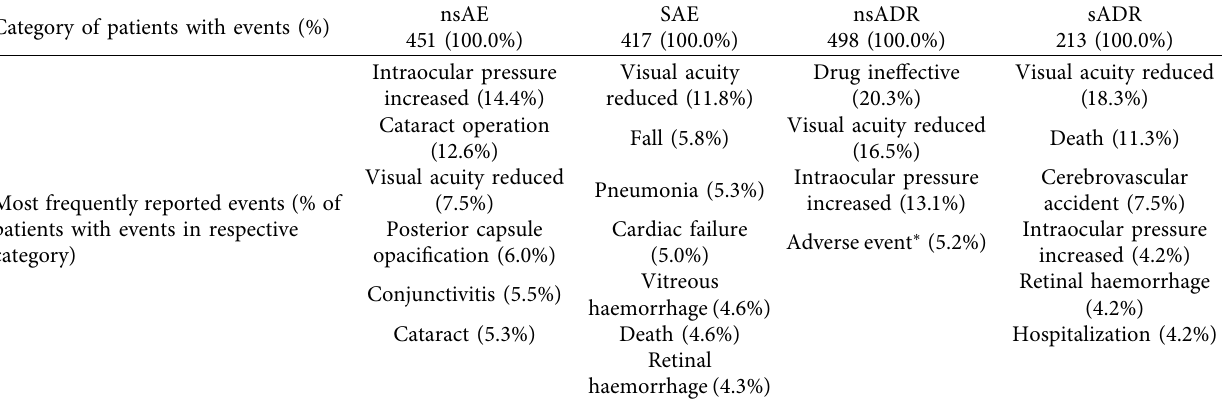
Table 2: Most commonly reported adverse events (MedDRA PT level), by category. nsAE Category of patients with events (%)